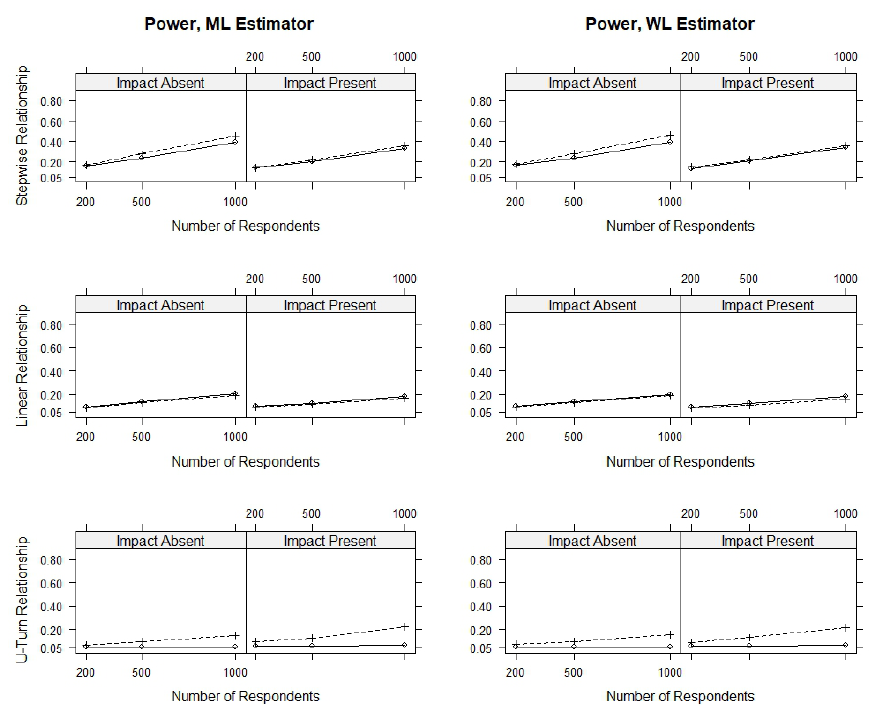
Figure A6. Power of two tests against unbalanced DIF in the β parameter for modules of 18 items. All items are used for ability estimation. The unbroken line presents the results for the linear logistic regression test, the broken line presents the results for the score-based bootstrap